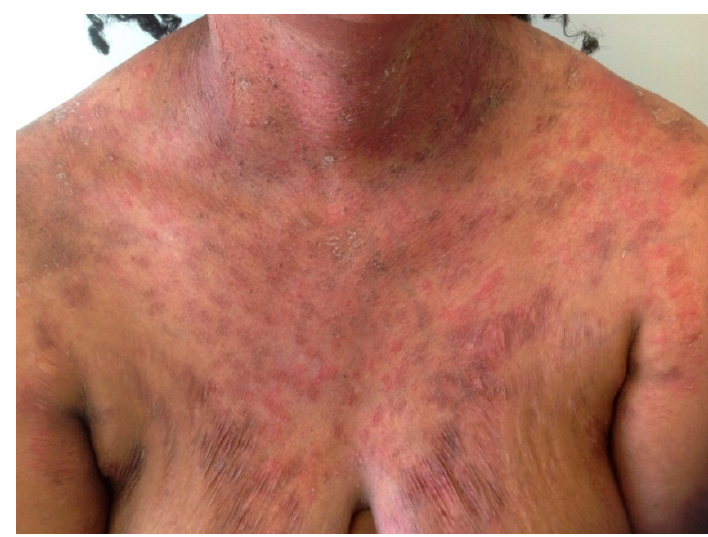
Figure 2. Topical corticosteroid-induced striae and tinea incognito.